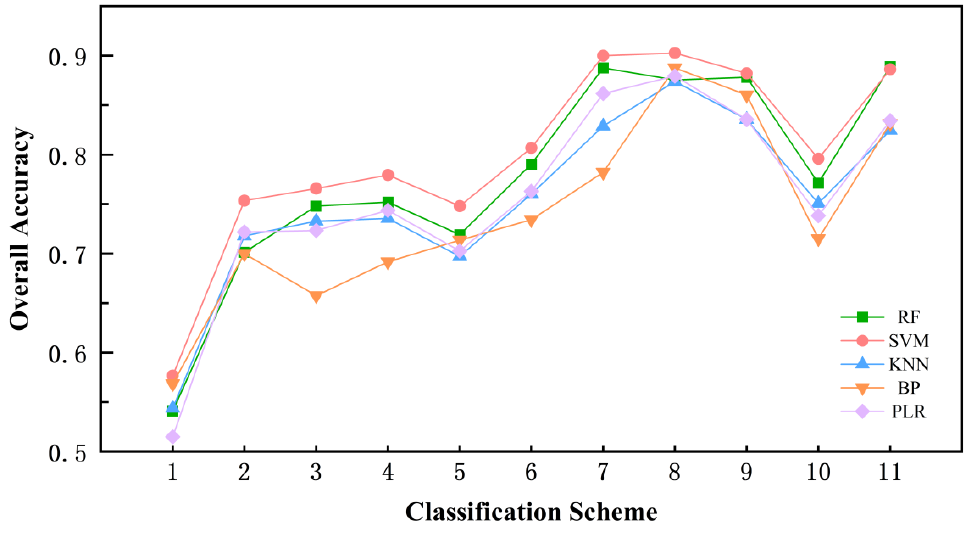
Figure 2. Overall accuracy of classification schemes.